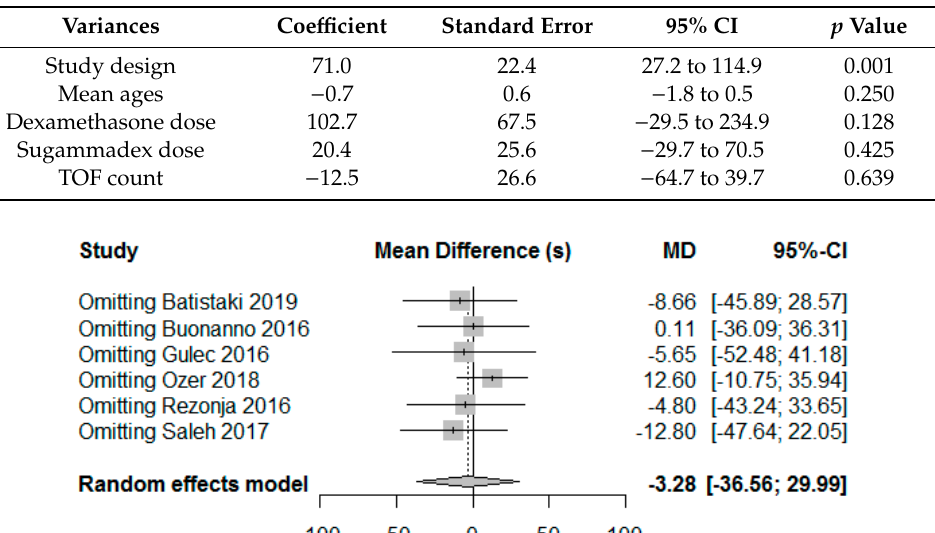
Table 2. Meta-regression for the potential sources of heterogeneity.